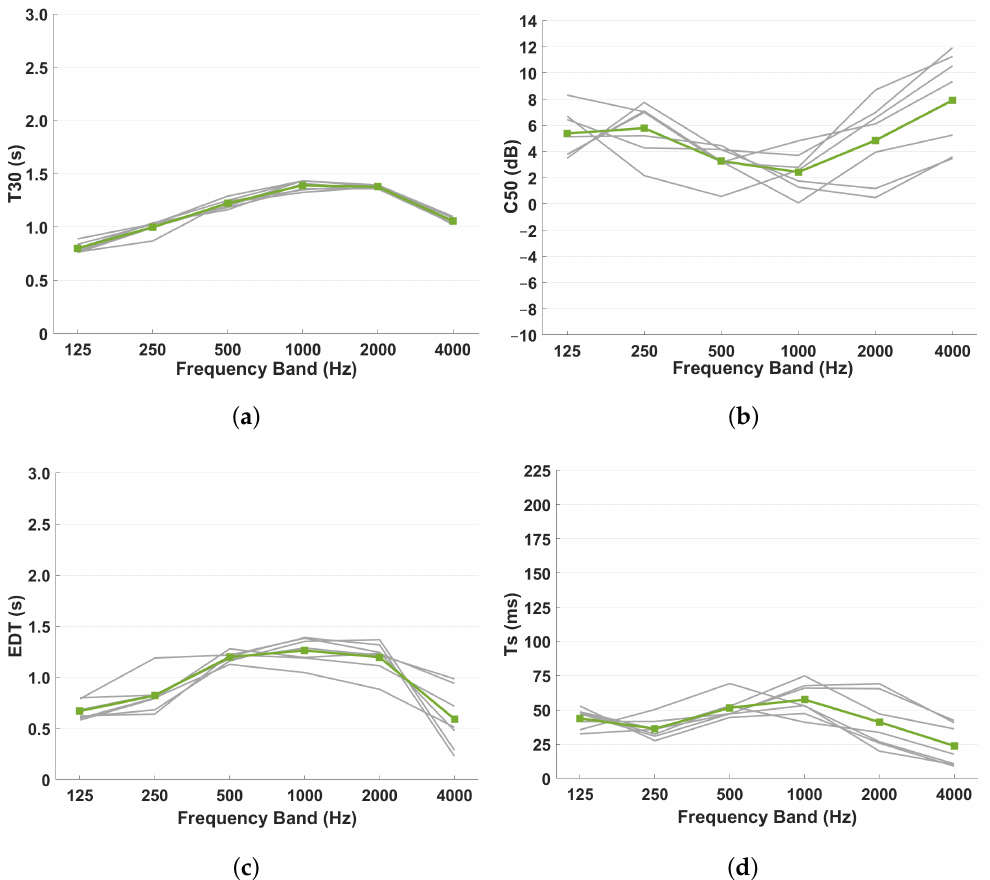
Figure 16. Results of the seven individual measured positions in the modern House of Commons and the average values across frequency bands for ( a ) T30, ( b ) C50, ( c ) EDT and ( d )